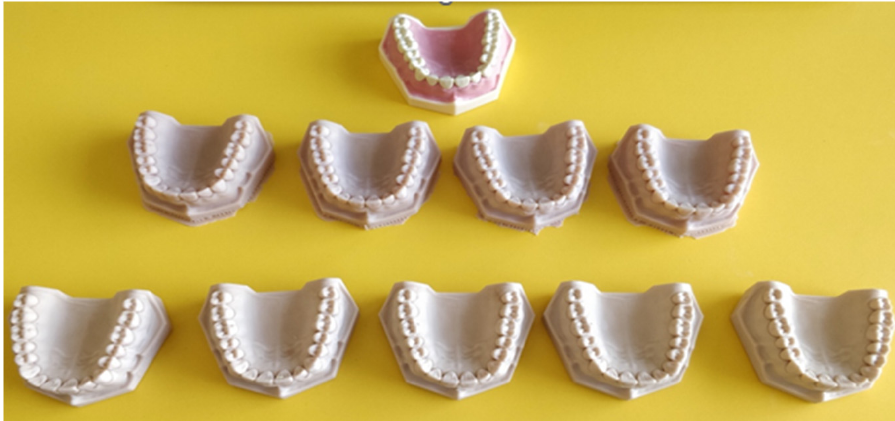
Figure 2. Typodont and 3-D printed models used in the study. At a later stage in the study, using the GOM ATOS Capsule (Zeiss™ Gmbh, Braunschweig, Germany) scanner, the models printed previously were scanned again for comparison with the benchmark. The models were covered with an antireflexive pow- der to avoid any shine and so that the measurement conditions were preserved for